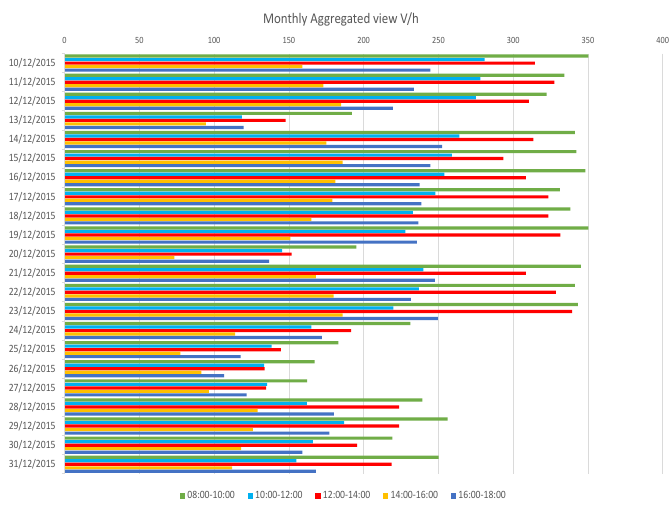
Figure 12. Aggregated vehicles per hour data by time slots for the latter 3 weeks (reduced only for a better readability) of December